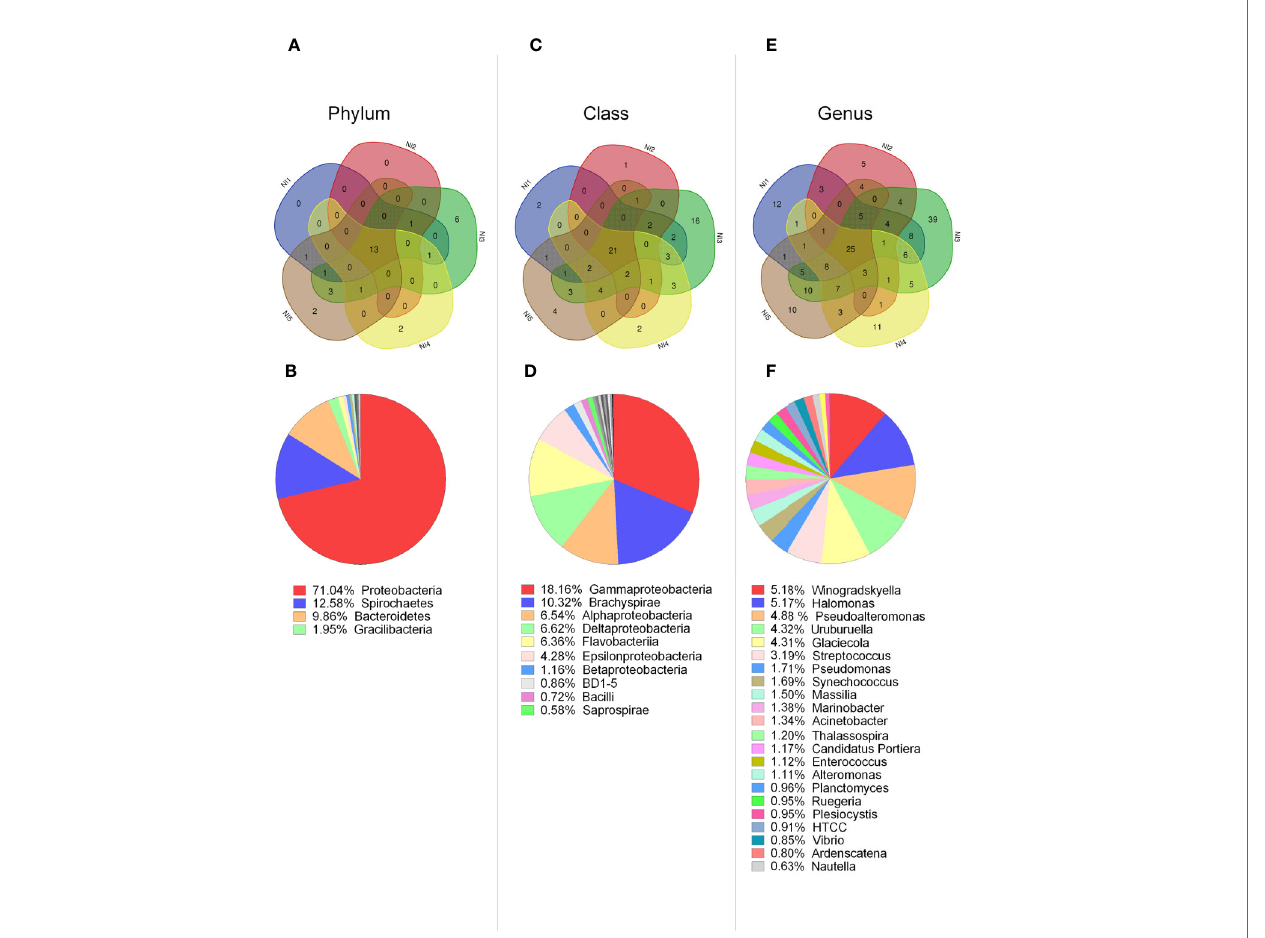
FIGURE 1 | Characterization of bacterial communities present in hemolymph from single scallops determined by 16S rDNA deep amplicon sequencing. Upper panel: Venn diagrams indicate the number of common and distinct bacterial groups at phylum (A) , class (C) , and genus (E) levels between fi ve non-stimulated individuals. Lower panel: Relative abundances of common bacterial groups at phylum (B) , class (D) , and genus (F) levels. Bacterial groups with relative abundances higher or closer to 1% are shown for each taxonomic